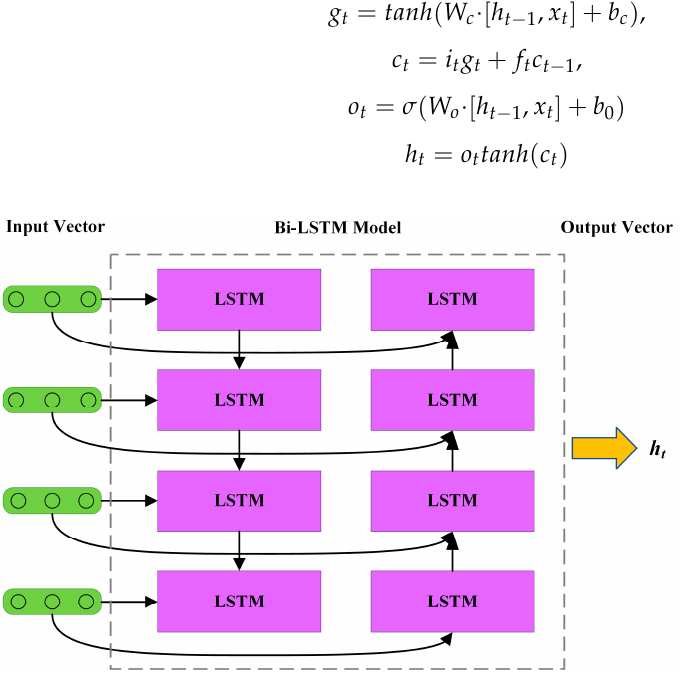
Figure 4. The process of Bi‑LSTM circulation.